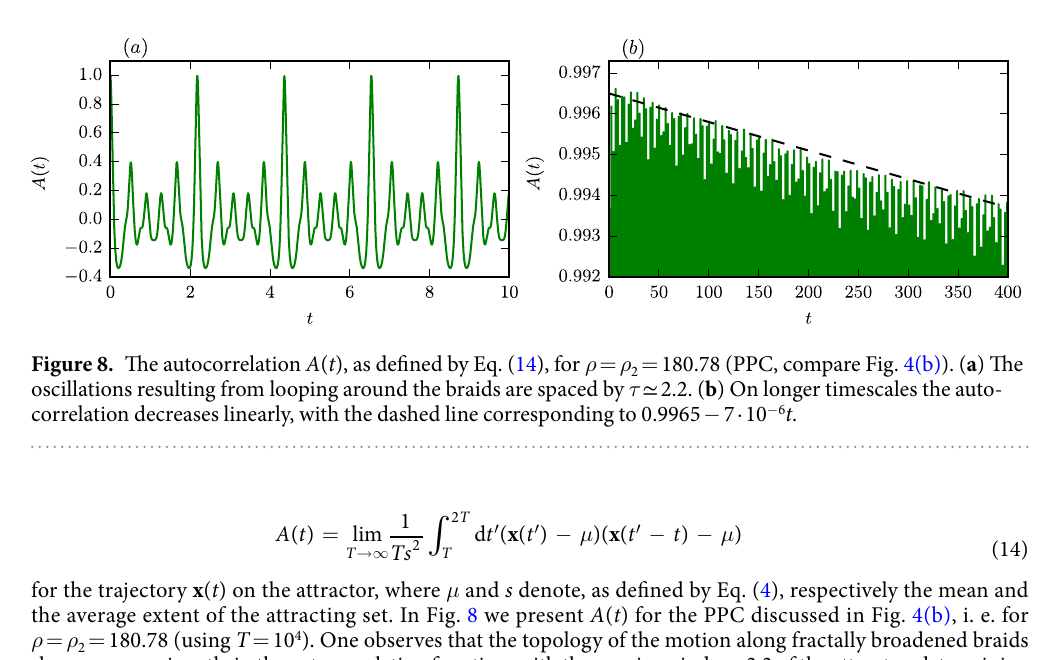
(l) of the local Lyapunov exponents λ (l) for the Lorenz attractor; the Figure 7. The probability distribution λ p ( ) i i global Lyapunov exponents λ i given in the legend and indicated by arrows in the plot are the average of the respective distributions. The standard deviations are s m = 14.3, s 2 = 5.1 and s 3 = 14.3 in ( a ) for ρ = ρ 1 = 180.70 (strong chaos) and s m = 14.6, s 2 = 5.6 and s 3 = 14.8 in ( b ) for ρ = ρ 2 = 180.78 (PPC). A direct connection between the functional form of the distributions of Lyapunov exponents with the dynamics of PPC is not evident. For the PPC the variance of the local neutral exponent λ l 2( ) is an order of magnitude larger (5.6 vs. 0.47) than the corresponding maximal Lyapunov exponent.